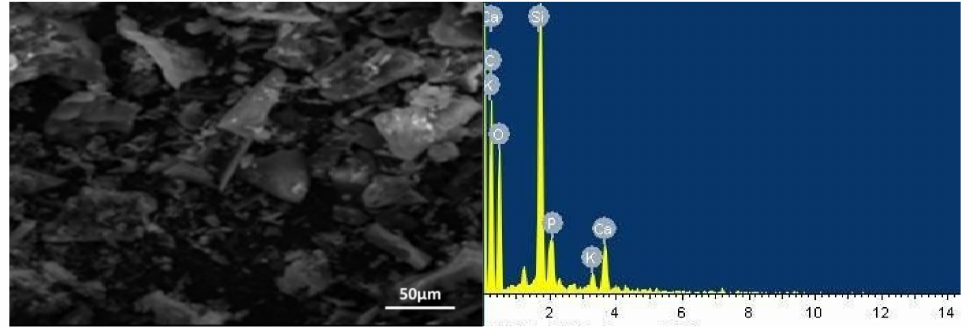
Figure 3. SEM (at 500 × ) and EDS image of RHA.